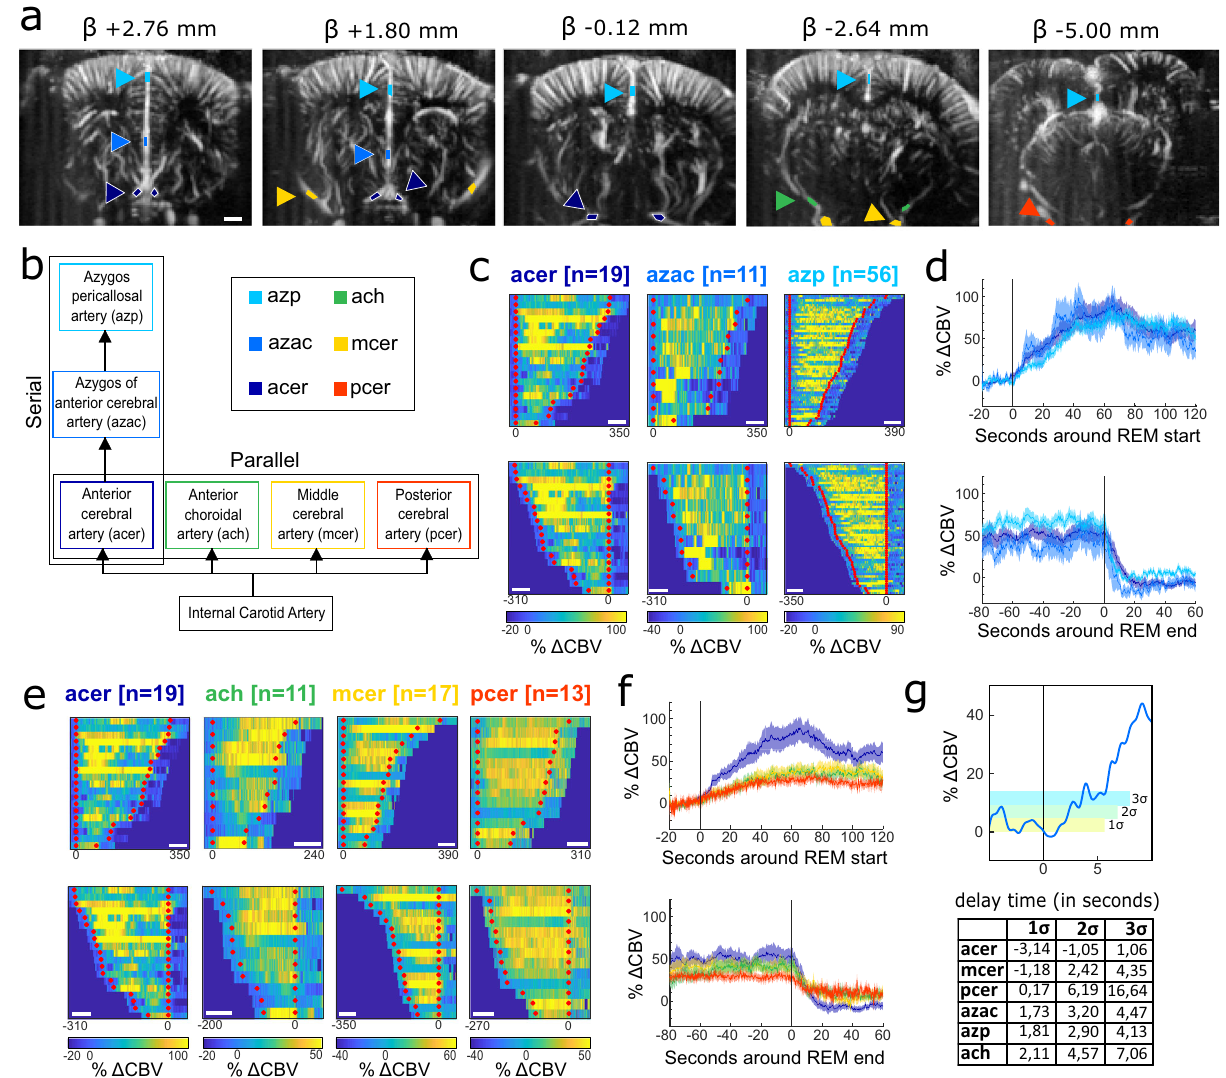
Fig. 4 Spatiotemporal dynamics of the arterial supply during REM sleep suggests a preferential irrigation in anterior cerebral areas. a Typical Doppler image (in 5 imaging planes) illustrating the nature and location of the 6 arteries, where the hemodynamic changes were measured, respective to REM episodes (colored arrows, color code: in legend b ). b Hierarchical representation of the 6 different vessels studied, separated in two groups: one within the same branch and the others at the same level and in different branches (according to Xiong et al. 2017). c and e Representation of the delta CBV in each type of blood vessel over time during all the REM episodes, either aligned to the beginning of REM (top) or the end of REM episodes (bottom). d and f : averaged delta CBV over time calculated from c and e , aligned either to the beginning of REM (top) or the end of REM episodes (bottom). Solid line represents the mean and shading represents the distribution. Beginning and end of REM episodes are indicated by red dots in c & e or vertical lines in d and f . g (top) Averaged representation for the azygos anterior cerebral artery (azac) centered on the beginning of REM and the 3 standard deviations of the averaged signal ( σ ). The table below shows the averaged times (in seconds) for each vessel to reach the 3 different standard deviations. Scale bar from a = 1 mm. Scale bars in c and e = 60 s. In c and e : each color bar is applied for the blood vessels, irrespective of their alignment to the beginning or end of the REM